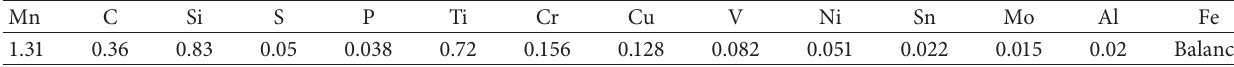
Table 1: Chemical composition of 1538MV steel (%wt).